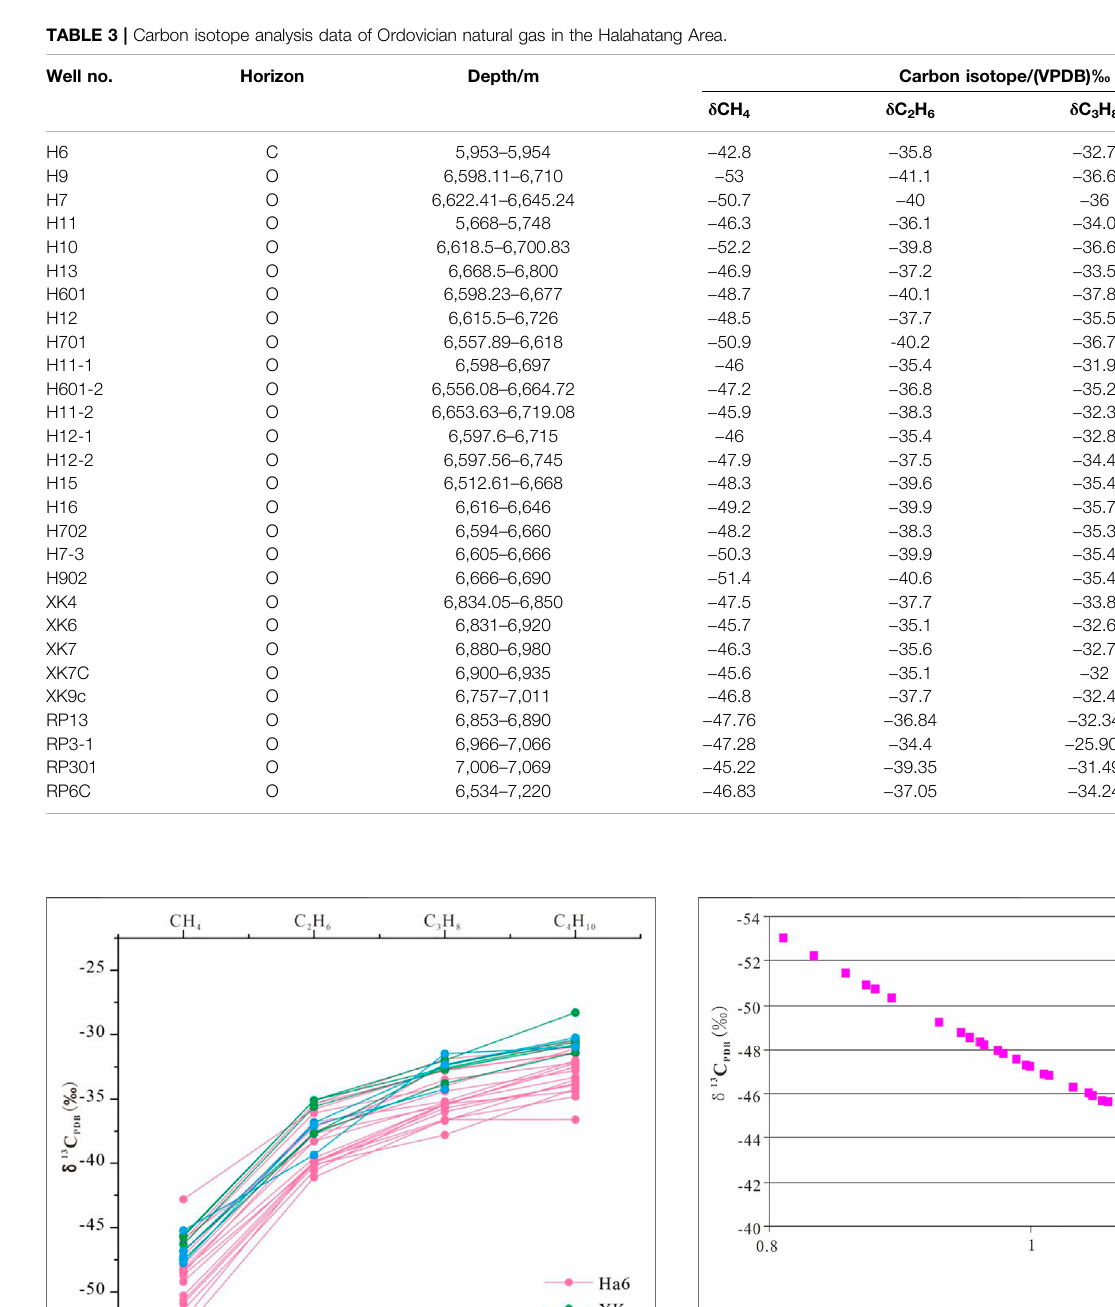
FIGURE 11 | δ 13 C 1 -Ro relationship diagram of Ordovician natural gas in the Halahatang